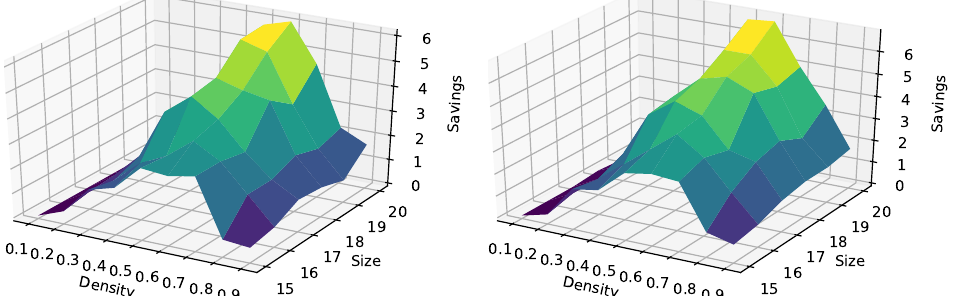
Figure 2: Average XOR count difference of the best ALOY circuits found by BP and A1